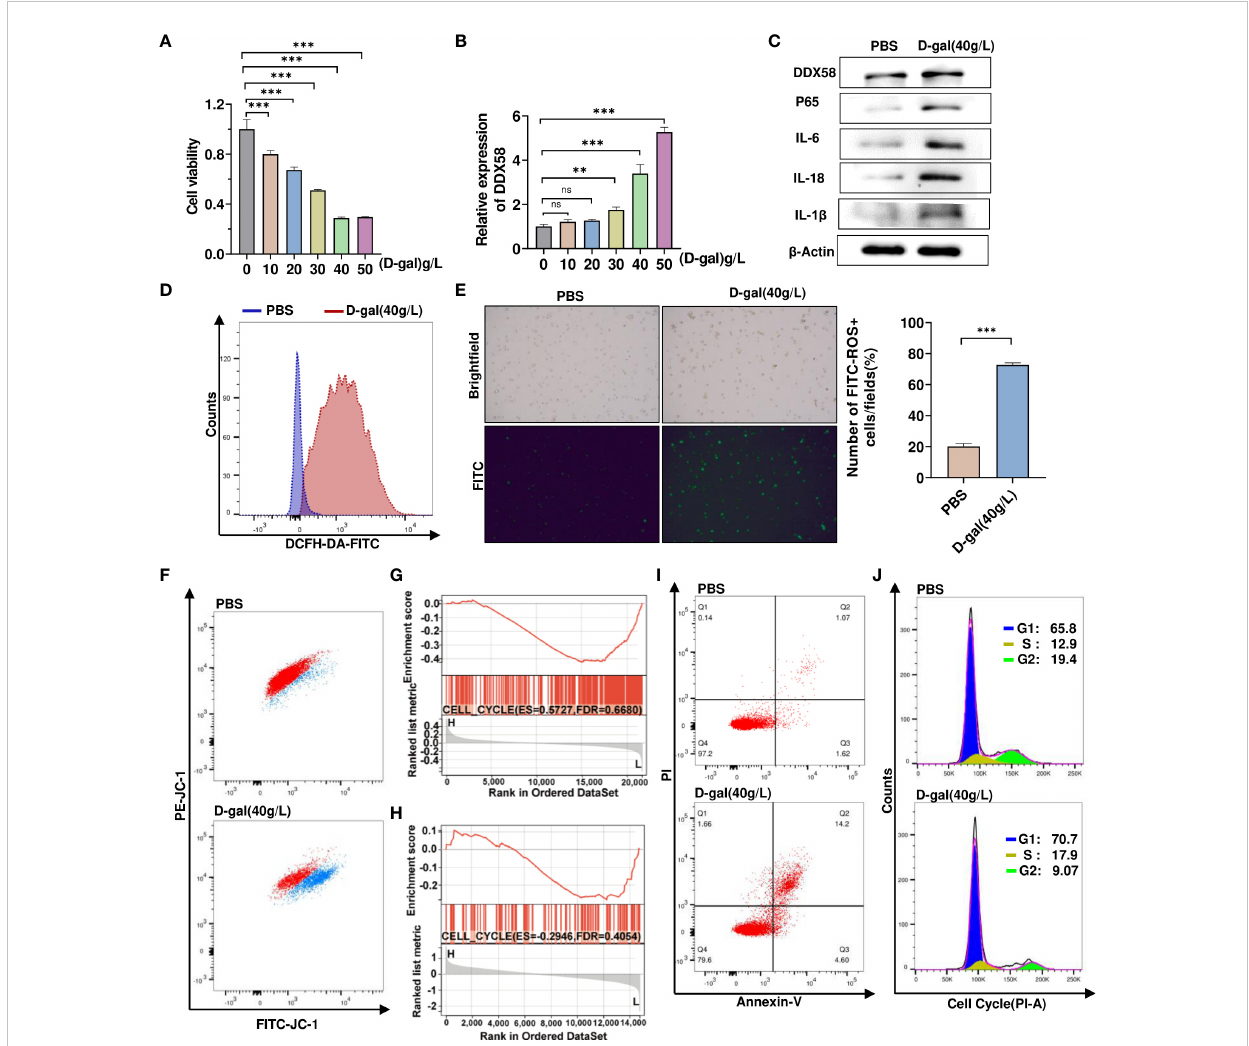
FIGURE 5 D-gal- induced cell growth arrest and chronic in fl ammatory response. (A) CCK8 analyzes TM4 cell viability treatment with varied D-galactose concentrations. *** p < 0.001; ns indicates no statistical signi fi cance. (B) RT – qPCR was used to detect mRNA expression of DDX58 after treatment with various doses of D-galactose. ** p < 0.01, *** p < 0.001; ns indicates no statistical signi fi cance. (C) Western blot analysis was used to detect the levels of protein expression of DDX58, p65, and in fl ammatory factors in control and D-gal-treated cells. (D, E) Flow cytometry and immuno fl uorescence were used to detect the levels of ROS in cells treated with 40 g/L D-gal. ***p<0.001. (F) Flow cytometry was used to detect the proportion of cells with low mitochondrial membrane potential after D-gal treatment. (G, H) GSEA results for cell cycle pathways in two datasets were compared between the samples with high and low DDX58 expression. (I) Using fl ow cytometry, the proportion of apoptotic cells were shown in control (1.07%) and D-gal- treated cells (14.2%). (J) Following D-gal treatment, fl ow cytometry was used to detect changes in cell